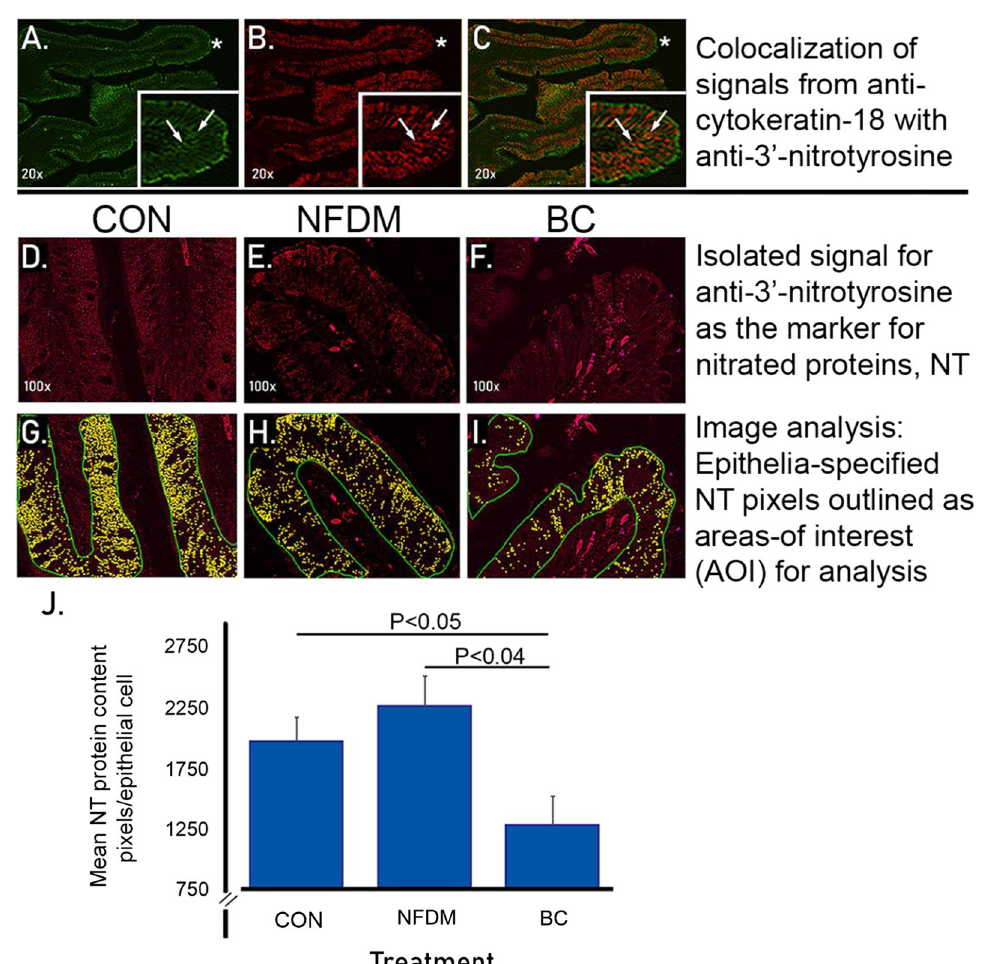
Fig. 3 Decreased protein tyrosine nitration (NT) in epithelial cells of villi in samples of ileum from chickens fed a BC-supplemented diet. Immunofluorescence is presented in Panels A – F and Image analysis depicted in Panels G – I . Epithelial cell (anti-cytokeratin 18 epithelial cell marker) presence is indicated by green fluorescence pixels ( A , C ). NT, as detected using an anti-nitrotyrosine antibody marker, is presented as red (cell presence, B and D – F , for isolated single channel image analysis quantification) or orange (colocalized in green cytokeratin 18-positive cells, C Representative patterns of image analysis-selected nitrotyrosine pixels ( G – I , yellow pixels) were summated and processed to yield the statistical analysis summarized in the lower panel bar graph( J ). Values are group means